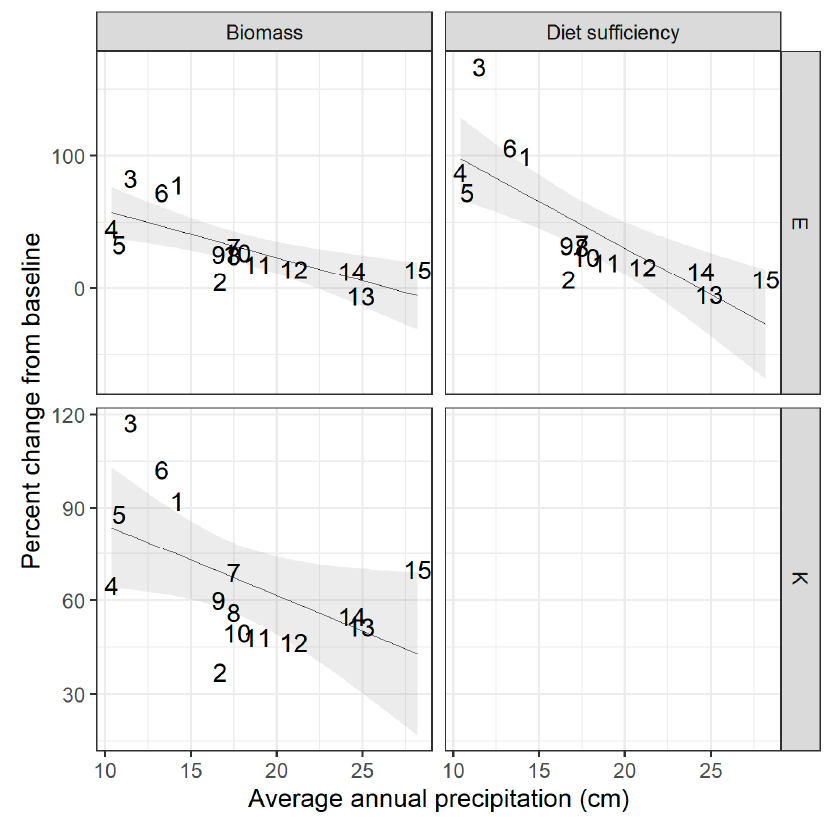
Figure A4. Percent change in biomass and diet sufficiency under fixed contrasts of doubled grazing intensity (scenario E) and removal of grazing (scenario K), each paired with elevated temperature and precipitation. Shaded area shows 95% confidence interval around best-fit line. Sites are shown here by their label from south (1) to north (15); see Figure 1 and Table A1 for site locations.